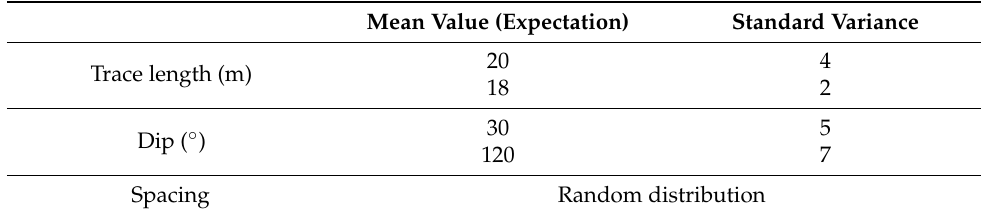
Figure 20. Relationship between P and Q. Table 7. Distribution parameters of the two groups of fractures.